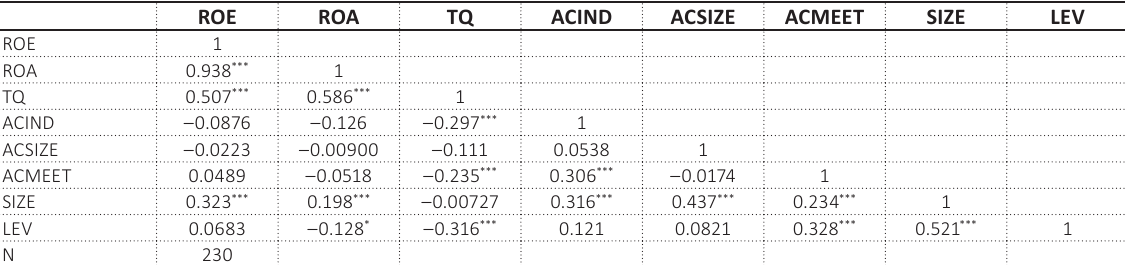
Table 4. Correlation matrix